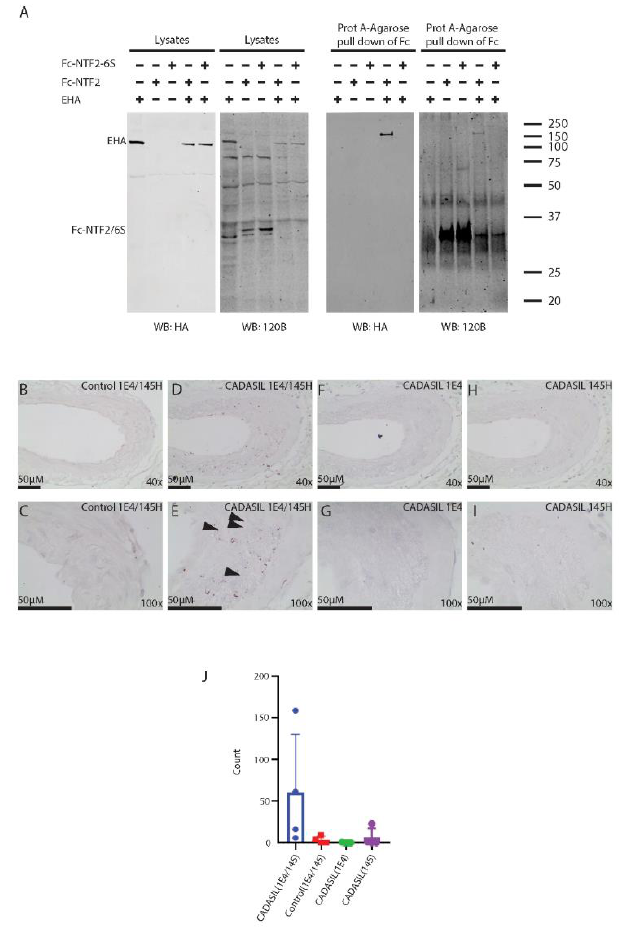
Figure 6. NOTCH3 protein co-precipitation with NTF2 and co-localization in vivo with NTF2. ( A ) To determine if NTF2 binds to NOTCH3 ectodomain, HEK 293 cells transfected with a combination of plasmids encoding EHA (NOTCH3 EGF-like domains 1–33 with HA tag), Fc-NTF2, and Fc-NTF2-6S, as indicated. Fc-NTF2 and Fc-NTS2-6S were generated by fusing coding sequences for NTF2 or NTF2 in which all cysteines were replaced by serines. Lysates were prepared for immunoblot analysis (left two blots) and then subjected to co-precipitation using Protein A-agarose to pull down Fc protein produced by transfection (Fc-NTF2 and Fc-NTF2-6S). Protein A-agarose pull downs (for Fc-proteins) were analyzed by Western blotting (right two blots marked above as Protein A-Agarose for Fc pull down). HA (Santa Cruz; mouse monoclonal antibody to detect EHA) and 120B (rabbit monoclonal antibody against NTF2 [22] and NTF2-6S) were used on the same blots. Expression of the Fc proteins in lysates was low but could be detected after pull down at 30 kDa (marked as Fc-NTF2/6S on the left). The EHA pull down band is expected to migrate at 150 kDa (marked on the left). PLA was performed on postmortem CADASIL and control brains using a rabbit monoclonal NTF2 antibody (145H [22]) and a mouse NOTCH3 antibody (1E4; [27]). Images of cerebral vessels are shown in the upper row ( B , D , F , H ) at 100 × magnification and in the lower row ( C , E , G , I ) at 400 × magnification. PLA signal was absent in control tissue ( B , C ) and present mainly in the medial layer of CADASIL tissue ( D , E ). Arrowheads in ( E ) are included that show sites of prominent PLA signal in the media of the CADASIL vessel. No signal was detected in CADASIL tissue in the presence of 1E4 alone ( F , G ) and rare signals were spotted in the presence of 145H ( H , I ). Scale bars are 50 microns. ( J ) Quantification of PLA signals that were counted from cerebral arteries from CADASIL and control brain ( n = 4 each); control signals were also quantified in samples that used only one antibody from matched vessels (in serial sections of the same brains; see detailed explanation in Supplemental Figure